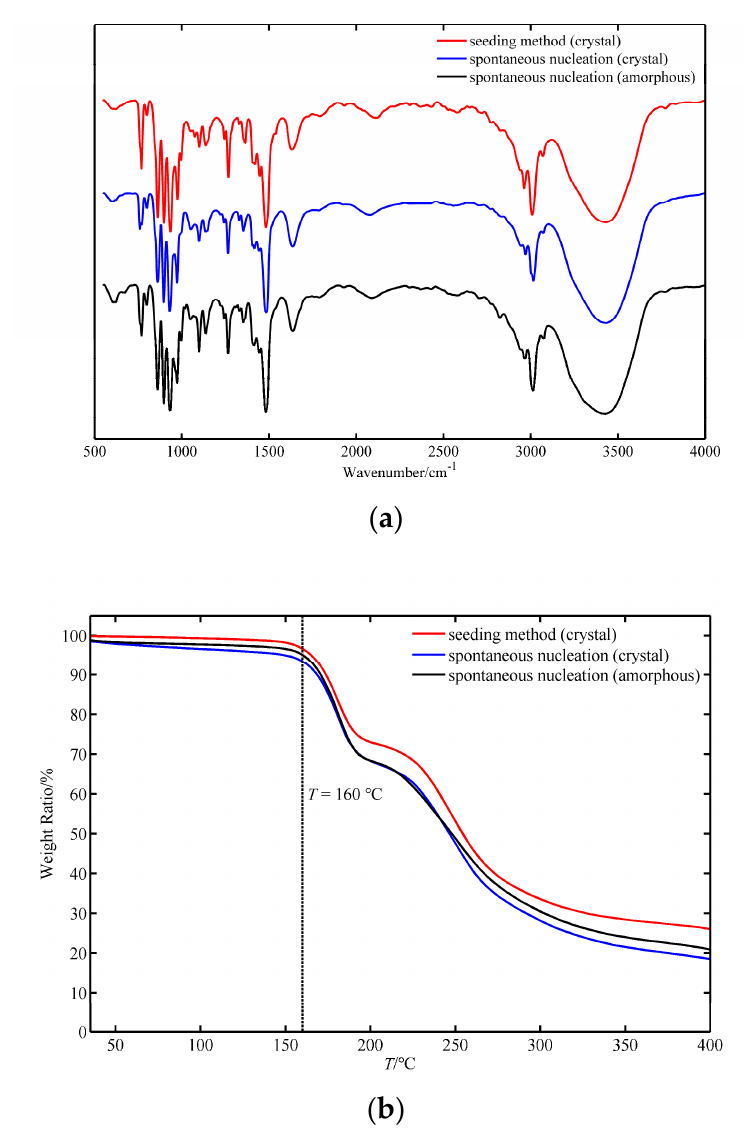
Figure 4. ( a ) IR spectrum of GTA product prepared by different methods. ( b ) TG curve of GTA product prepared by different methods.